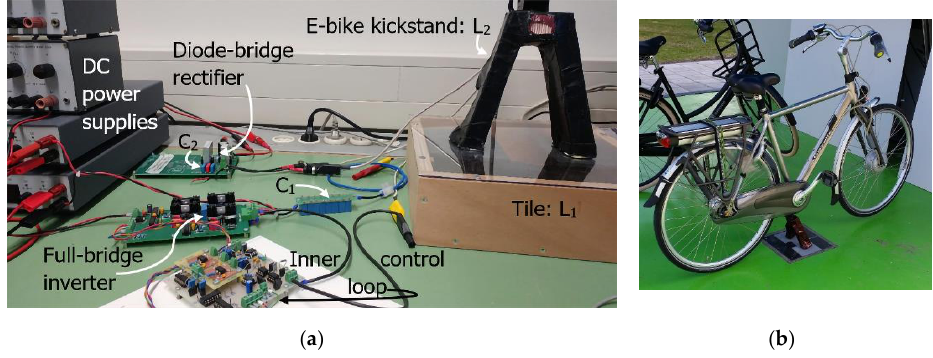
Figure 12. ( a ) Laboratory setup of the e-bike wireless charging system and ( b ) e-bike with primary coil placed below the tile in the station and secondary coil integrated into the kickstand.